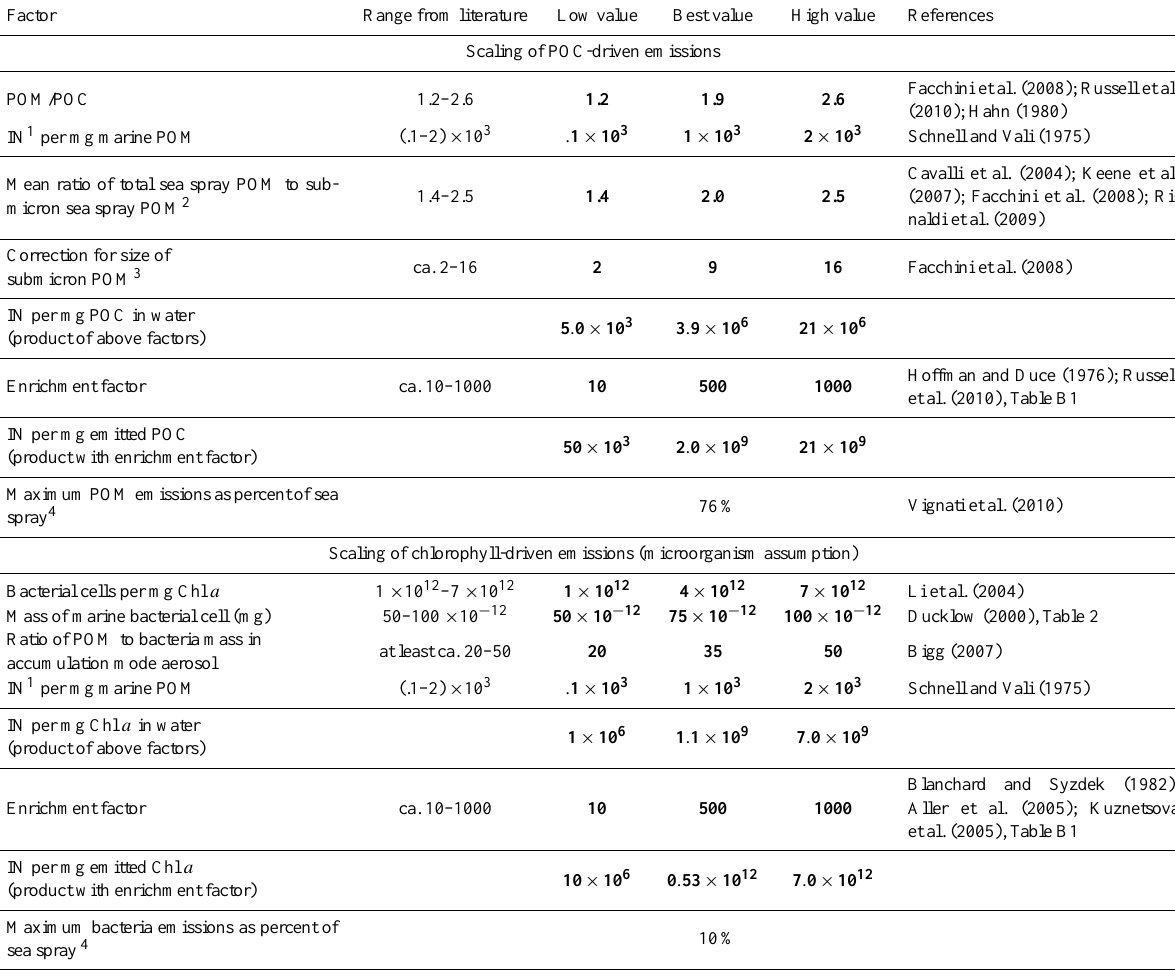
Table 1. Scaling factors applied in estimation of sea spray IN